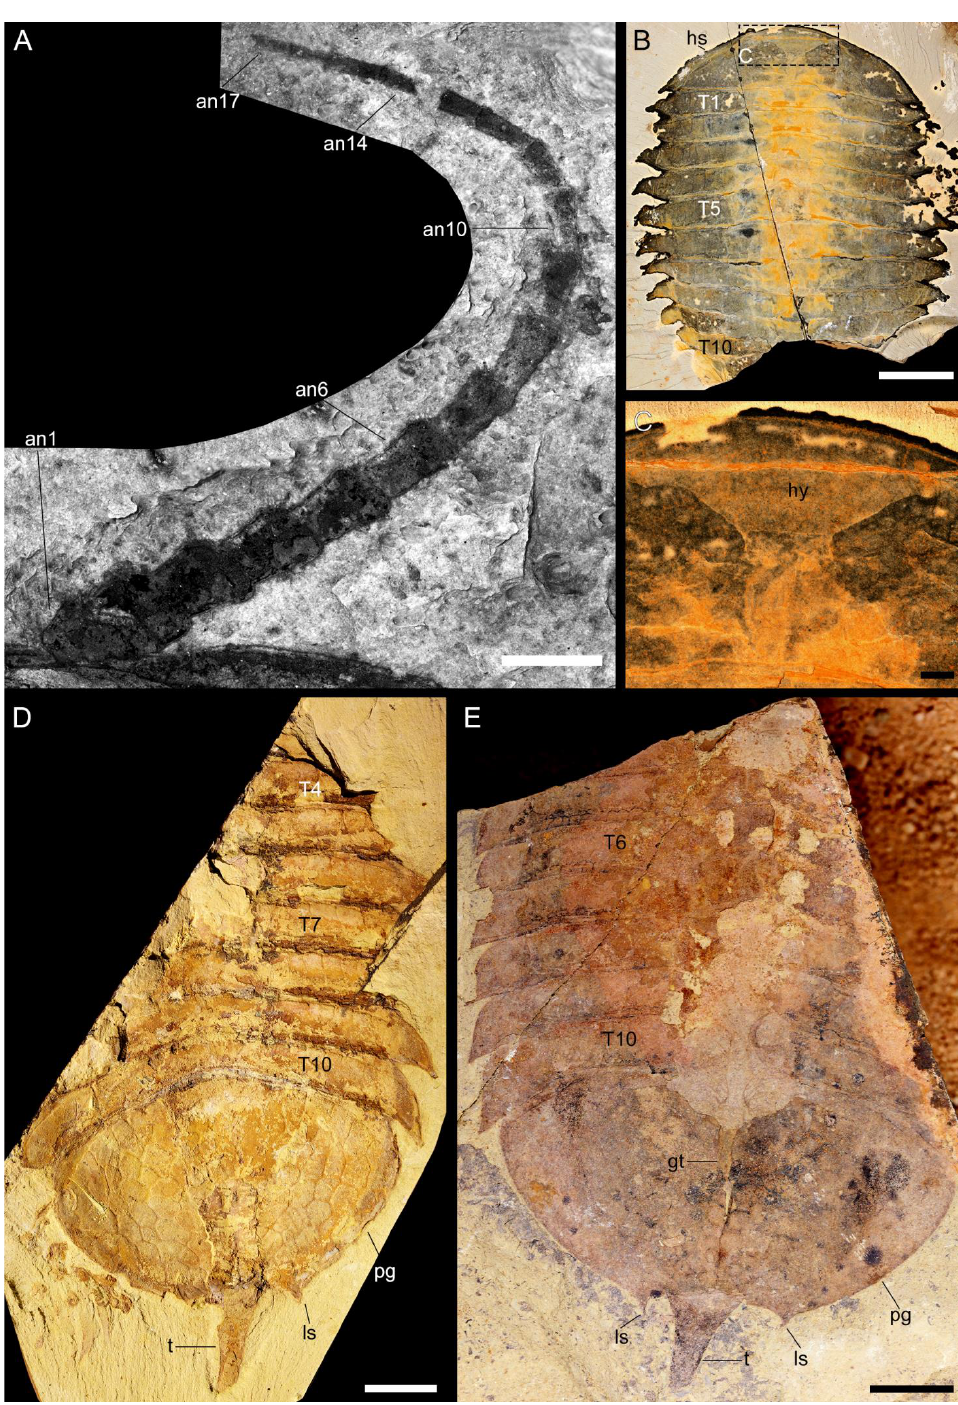
Figure A1. Fluorescent ( A ) and macro-photographic ( B – E ) images of Retifacies abnormalis. ( A ) Close-up of right antenna of YKLP 13927 in Figure 1A, showing a complete antenna with 17 annuli. ( B ) Dorsal view of YKLP 11433. ( C ) Close-up of hypostome in ( B ). ( D ) Dorsal view of YKLP 11426. ( E ) Dorsal view of YKLP 11435 showing gut trace of the posterior trunk. Other abbreviations: gt, gut trace. Scale bars: 1 cm in ( B ), 5 mm in ( D ), 2 mm in ( A ), 1 mm in ( C